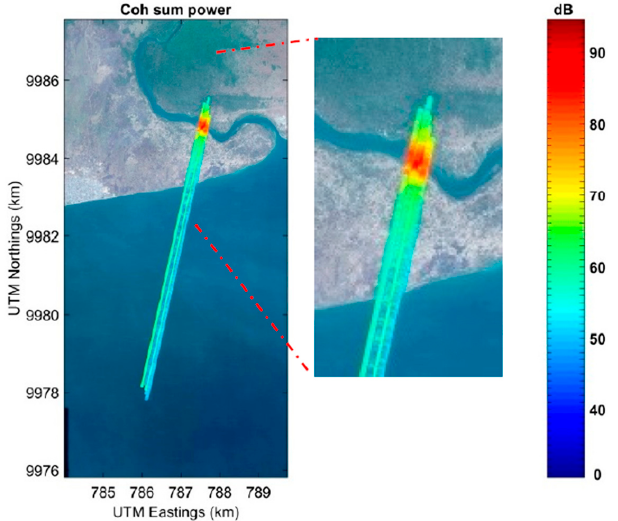
Figure 15. Seven altimeter passes crossing the river. Color bar indicates the power of the returned echoes (coherently